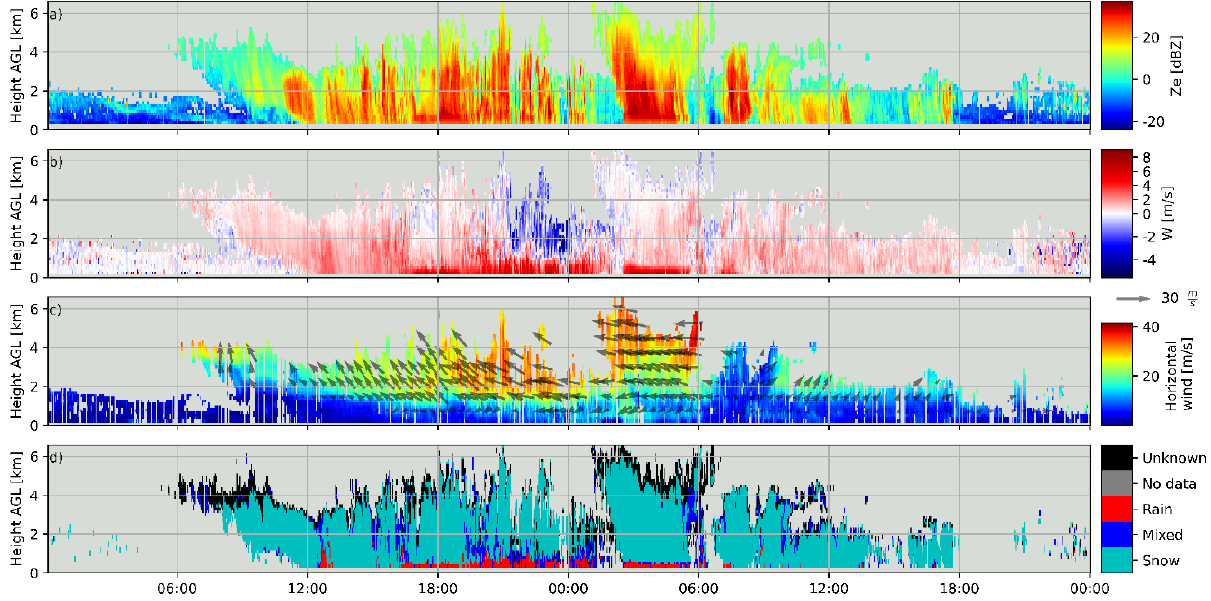
Figure 12. Method2 (A73 approach) processing applied to RWP observations recorded from 24 to 25 March 2017. ( a ) radar reflectivity, ( b ) vertical fall speed, ( c ) horizontal wind, module and direction and ( d ) precipitation type.